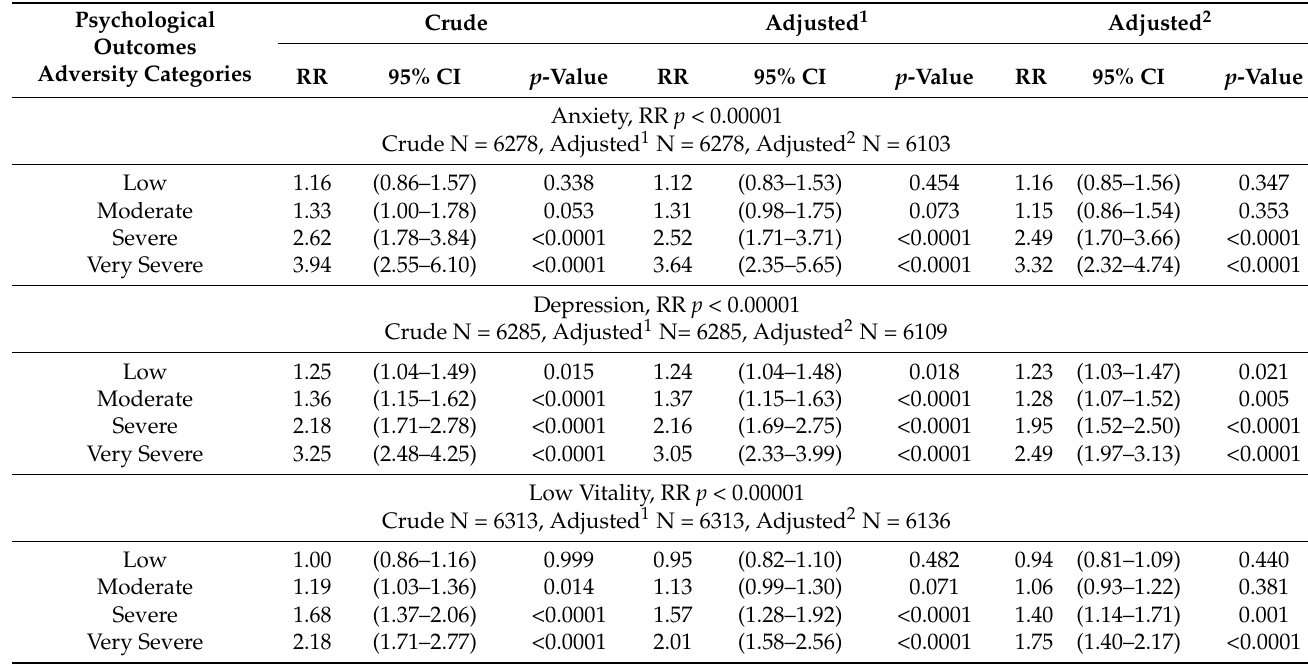
Table 6. Risk Ratio between WICAC and psychological outcomes.